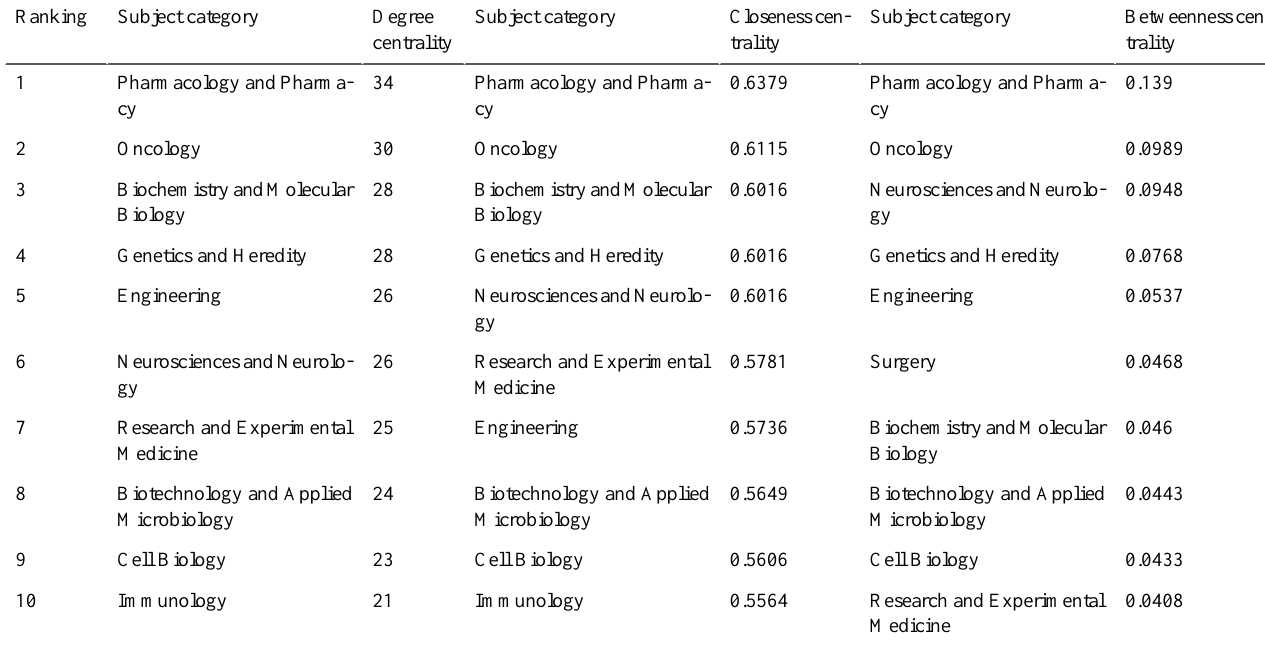
Table 4. Top 10 subject categories in terms of degree, betweenness, and closeness centrality in precision medicine